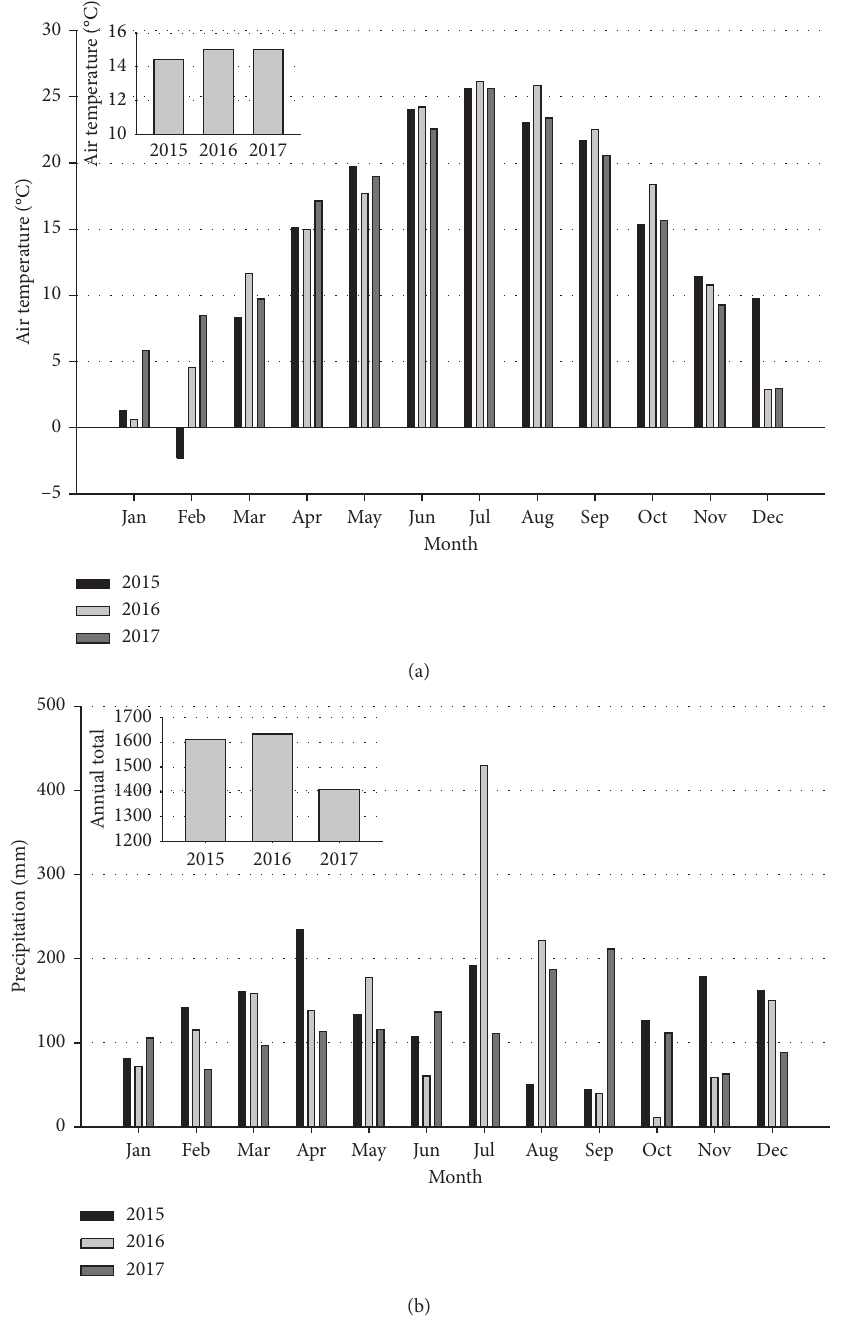
Figure 1: Average monthly air temperature (yearly average inset) and precipitation (yearly average inset) at the Logan farm for 2015, 2016, and 2017. Precipitation records are from the Logan County Mesonet Weather Data (38.12 ° N; 84.88 ° W)